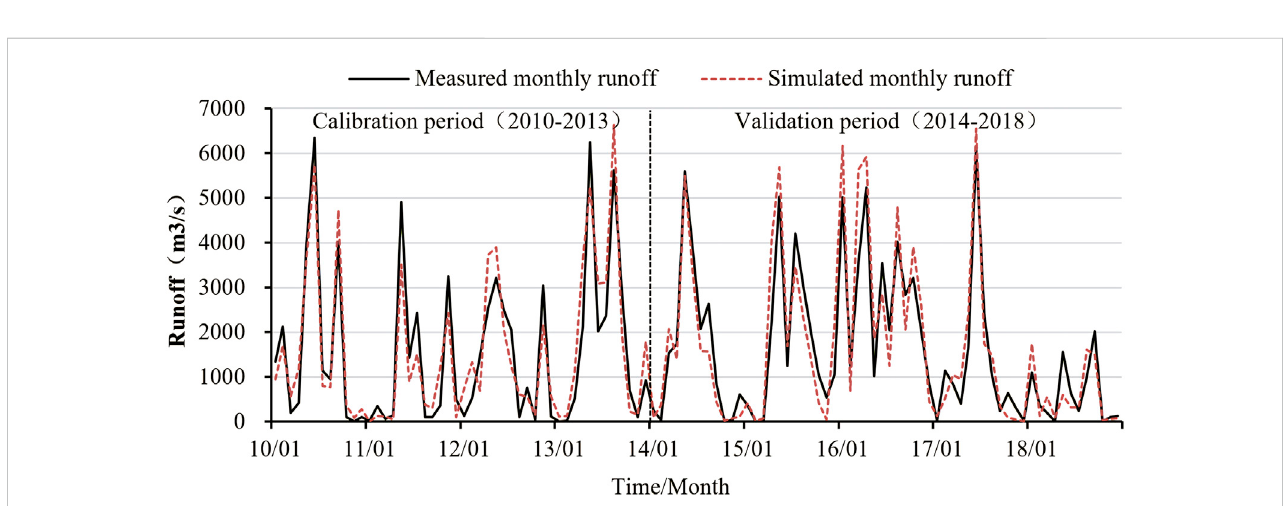
FIGURE 3 Comparison of observed and simulated runoff at monthly scale during calibration and validation